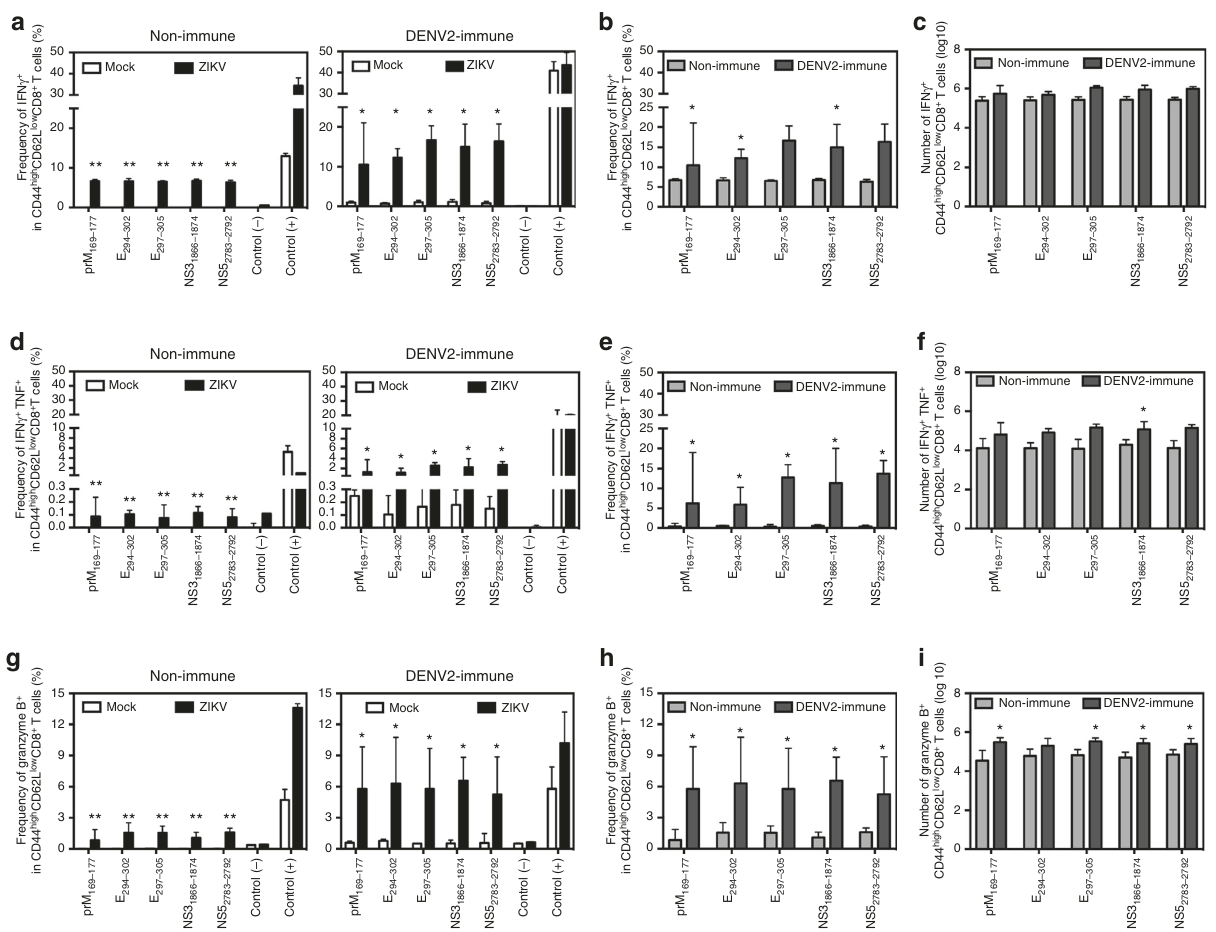
Fig. 6 Cross-reactive epitope-speci fi c CD8 + T cell response in spleens from Ifnar1-blocking Ab-treated WT dams on day 7 after ZIKV infection. Non- immune or DENV2-immune WT dams with transient Ifnar1 blockade were challenged with ZIKV at E7.5 or injected 10% FBS – PBS (MOCK) as described in Fig. 2. Seven days after ZIKV infection (E14.5), mice were killed, and spleens were processed for ICS analysis. a – c The percentages ( a , b ) and numbers ( c ) of CD44 high CD62L low CD8 + T cells producing IFN γ are shown. d – f The percentages ( d , e ) and numbers ( f ) of CD44 high CD62L low CD8 + T cells producing both IFN γ and TNF are represented. g – i The percentages ( g , h ) and numbers ( i ) of CD44 high CD62L low CD8 + T cells expressing granzyme B are shown. The following numbers of dams were used: Non-immune ( n = 6 MOCK and n = 5 ZIKV) and DENV2-immune ( n = 4 MOCK and n = 5 ZIKV). Data were pooled from two independent experiments and are expressed as median with interquartile range. * p < 0.05, ** p < 0.01. Two-tailed Mann – Whitney test was used to compare MOCK versus ZIKV-infected or non-immune versus DENV2-immune mice for each stimulation condition in a –